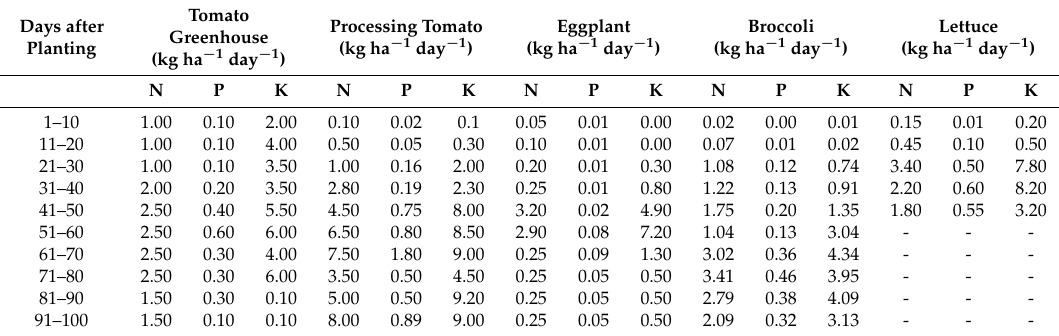
Table 2. Daily absorption rate of nitrogen (N), phosphorus (P) and potassium (K) (kg ha − 1 day − 1 ) of selected vegetables grown under drip irrigation after emergence or planting (adapted from Bar-Yosef